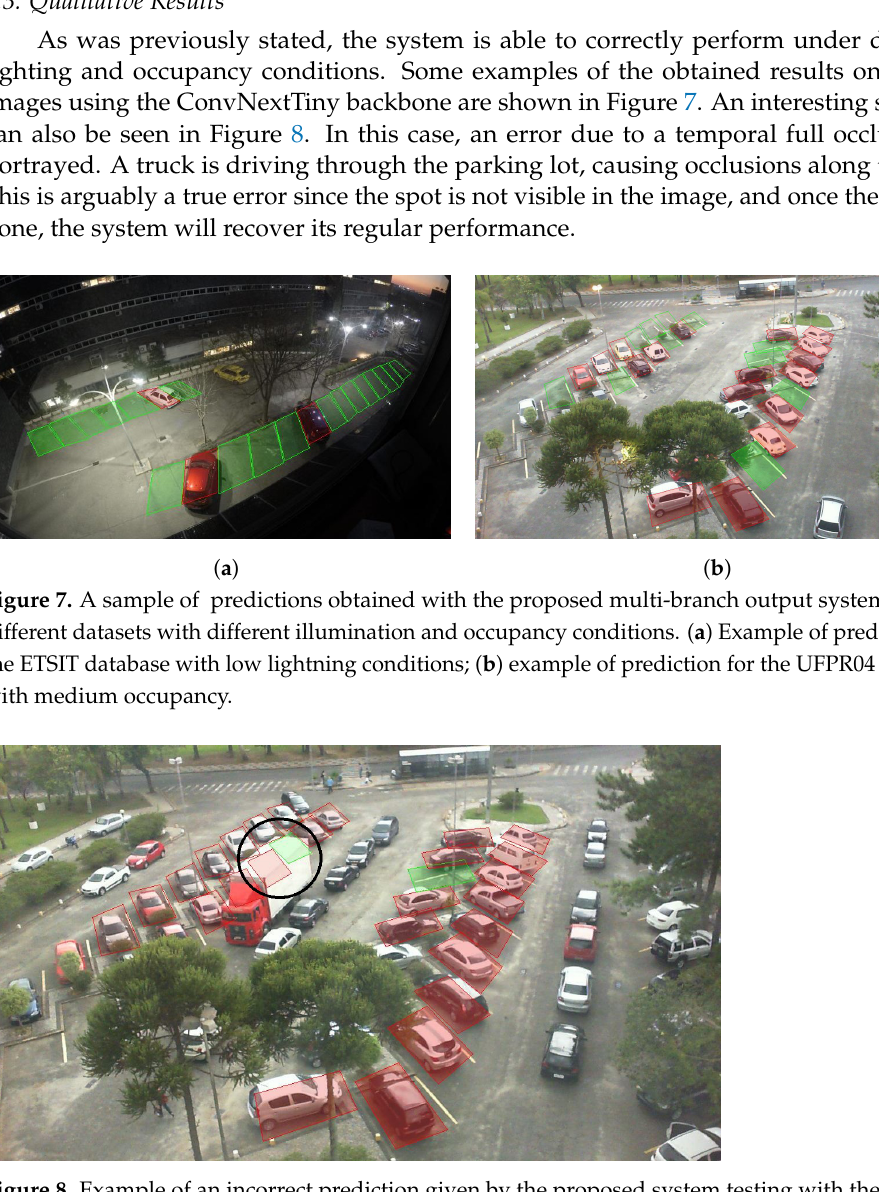
Figure 8. Example of an incorrect prediction given by the proposed system testing with the UFPR04 database due to a temporal full occlusion between